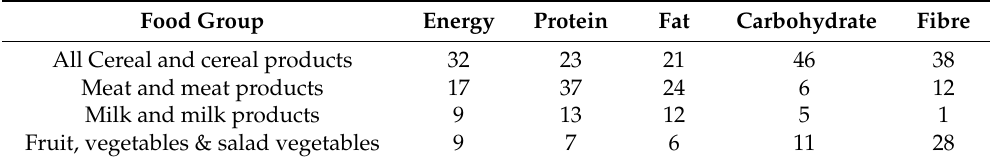
Table 2. Percent contribution to energy, macronutrient and fibre intake of UK adults aged 19–64